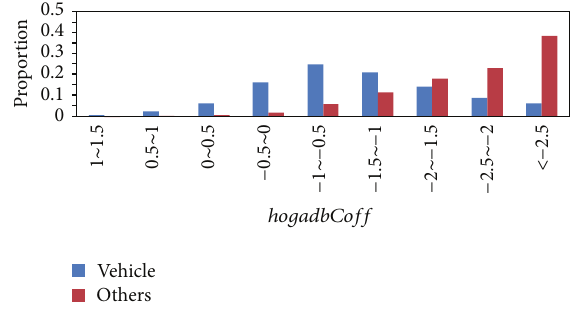
Figure 7: Statistic distribution of hogadbCoeff belonging to vehicles and interferences.